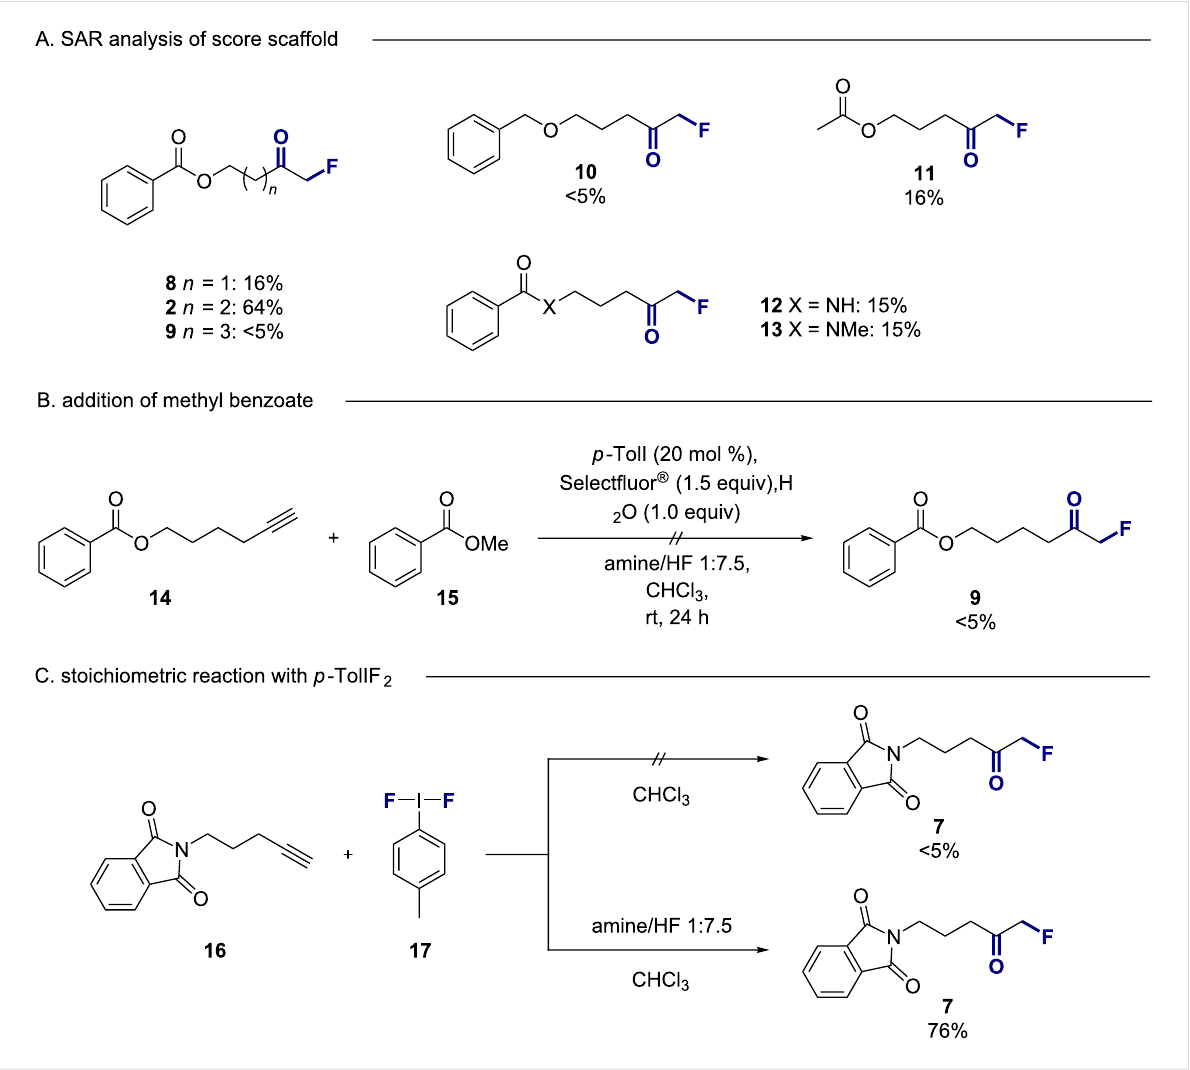
Figure 3: (A) Structure activity relationship of the core scaffold. (B) Exploring the effect of methyl benzoate as an activator. (C) Stoichiometric reac- tion with p -TolIF 2 17 and alkyne 16 . Yields refer to spectroscopical yields determined by 19 F NMR analysis of the crude reaction mixtures using ethyl fluoroacetate as an internal standard.